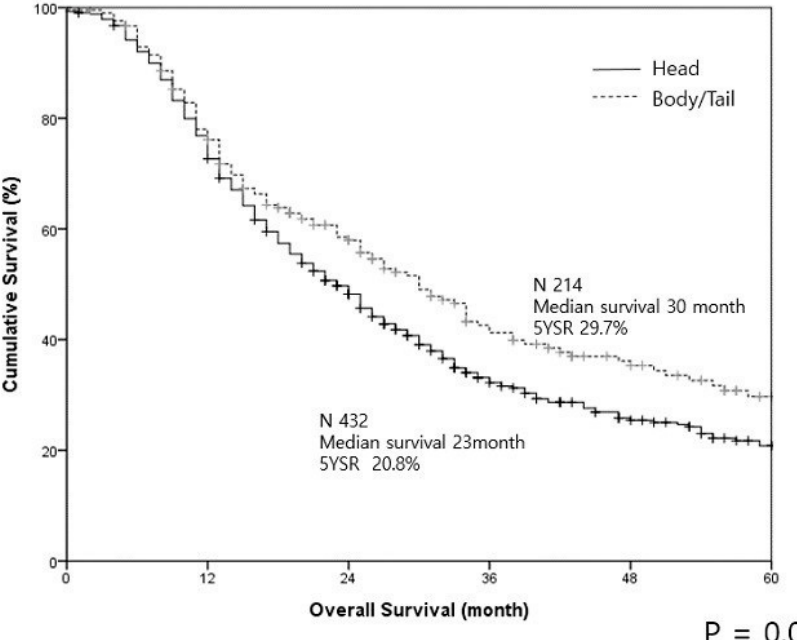
Figure 2. The survival curves of pancreatic cancer in the head/uncinate region and body/tail regions in resected patients are illustrated.